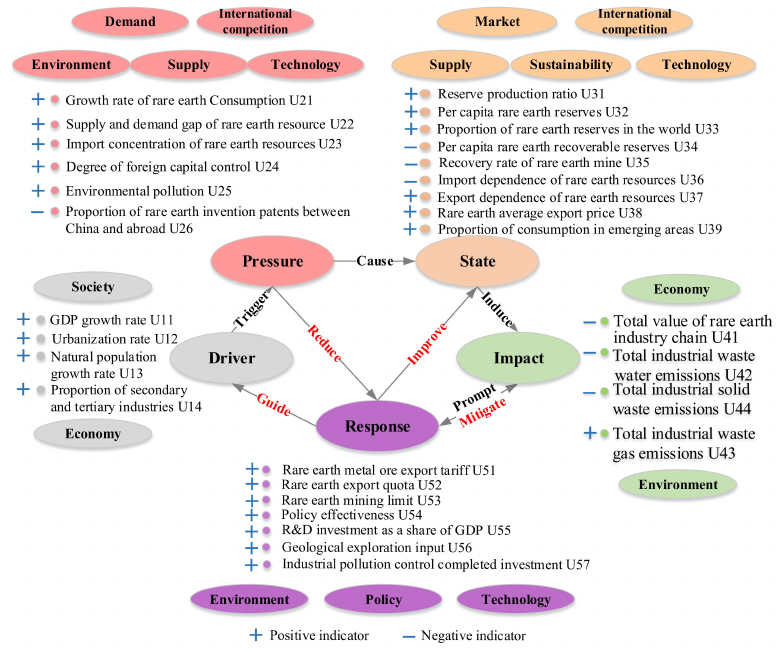
Figure 3. Index system